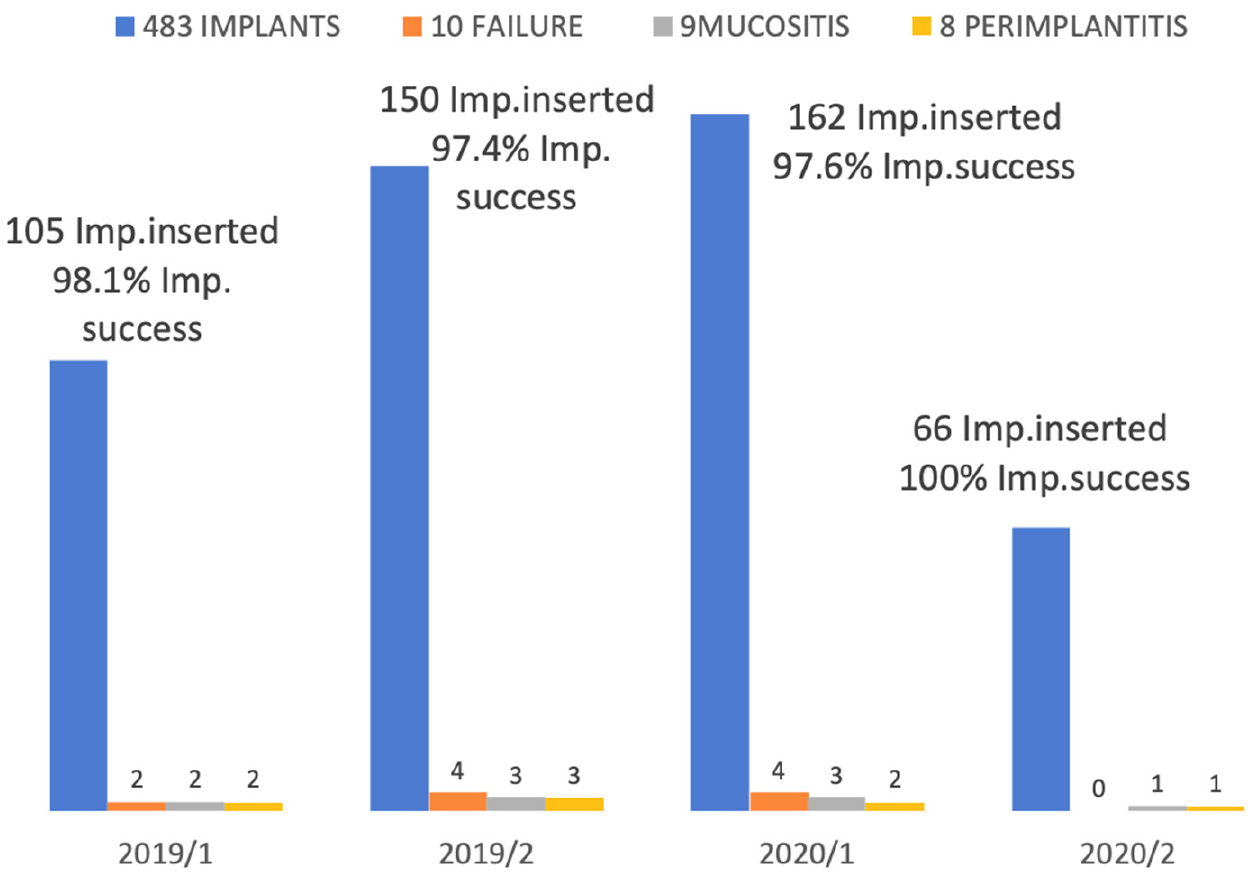
Figure 2. Numbers of implants inserted in ASP sites. success, failure, mucositis and periimplantitis rate detected.